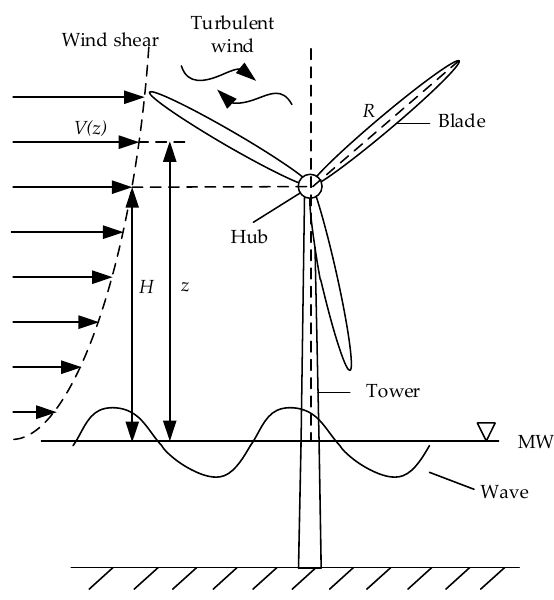
Figure 1. Operating environment of offshore wind turbine.